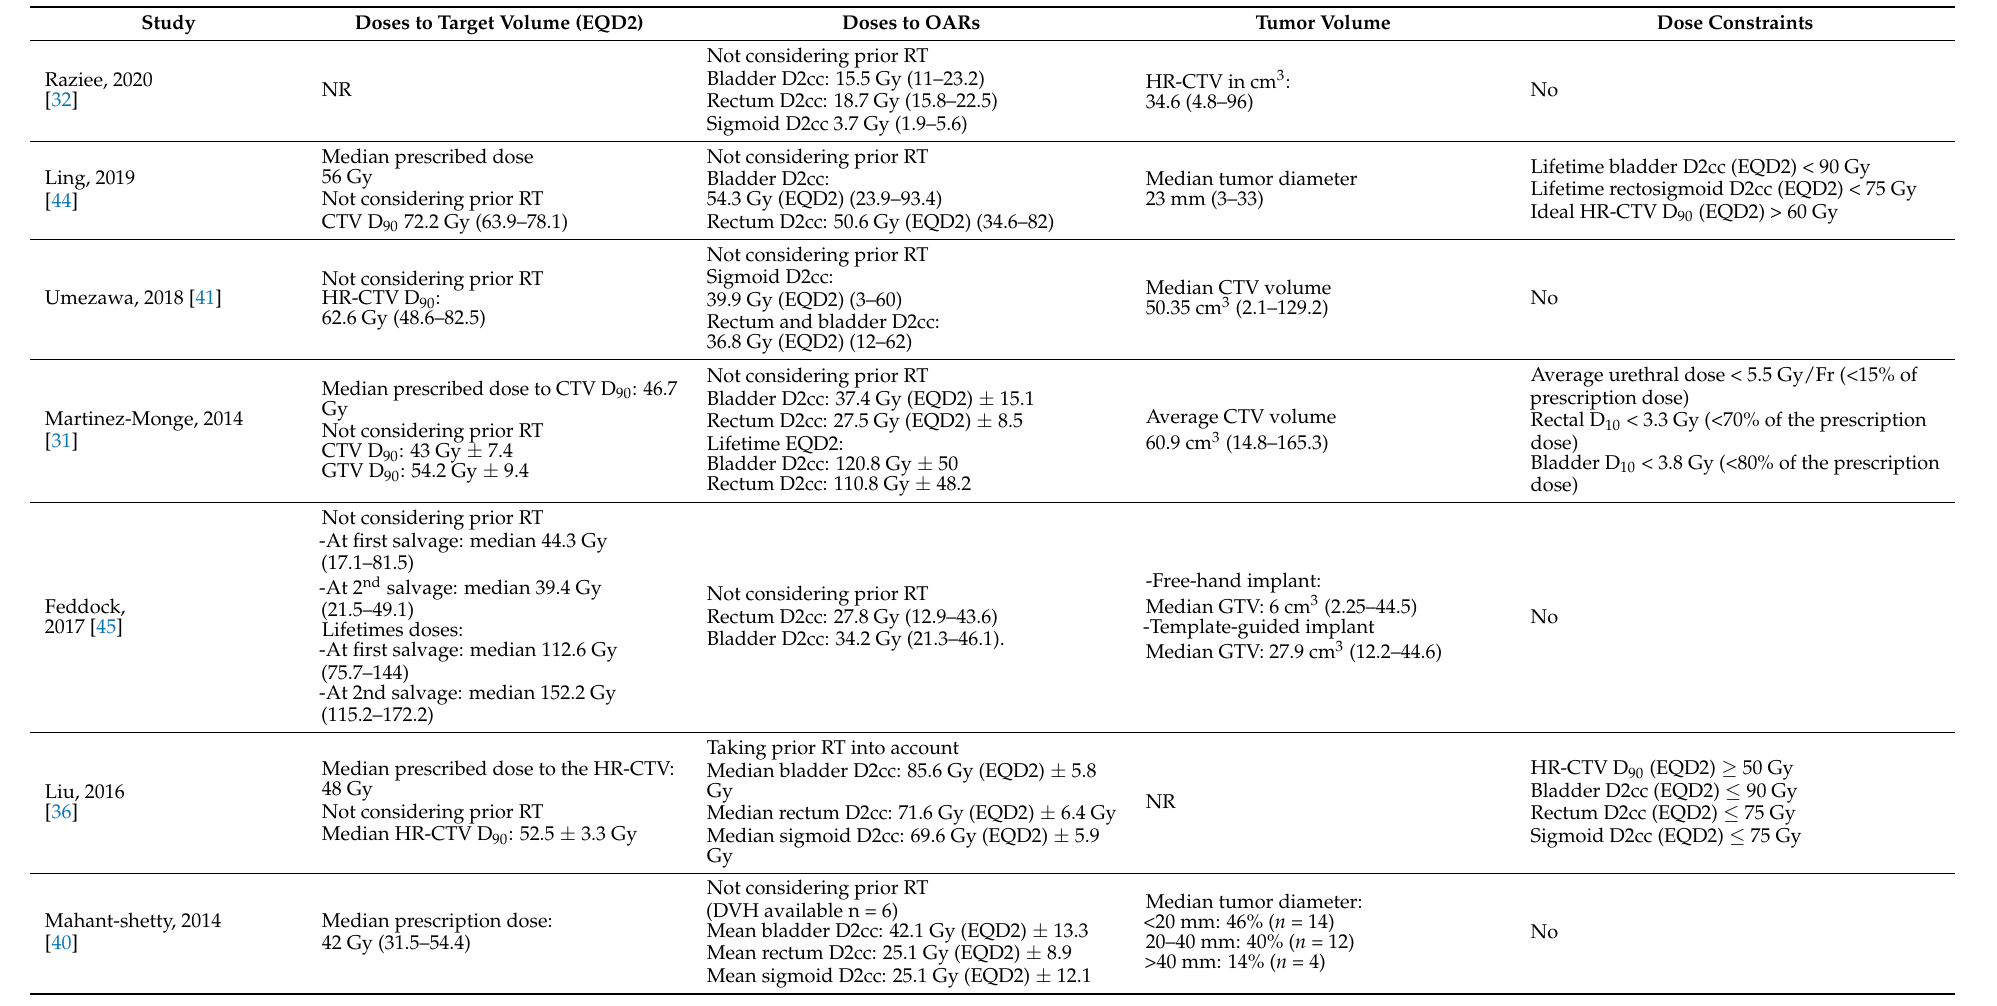
Table 3. Reirradiation 3D-IGBT dosimetric details and tumor